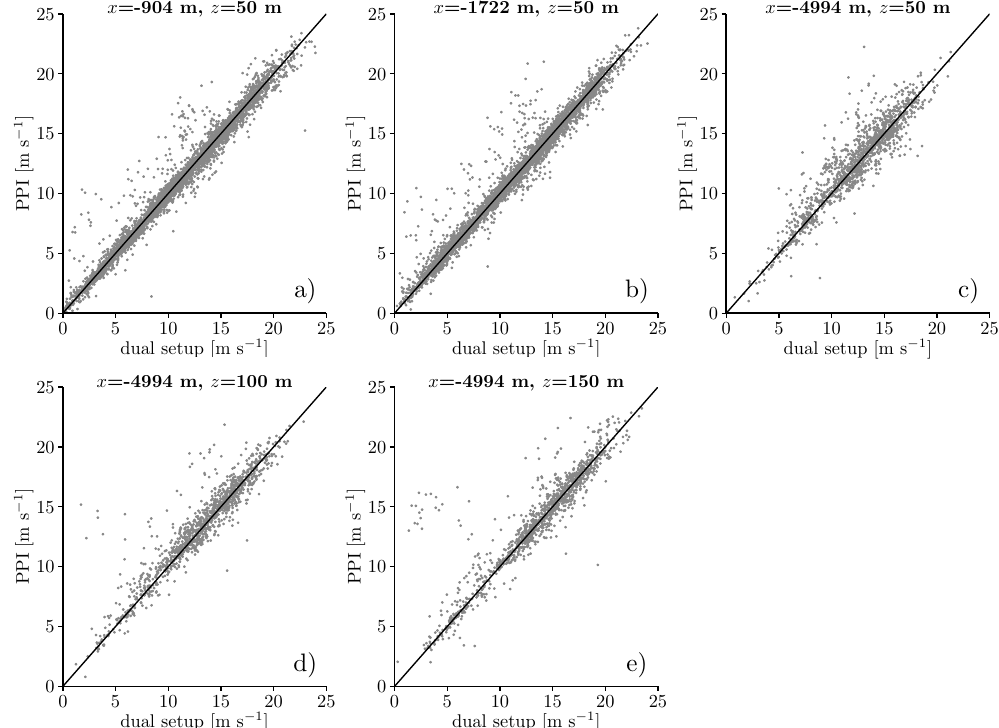
Figure 10. Scatter plots of the 10 min mean wind speeds for the PPI and dual setups (see text for details). A line through the origin with a slope of 1 is shown in black. The x -position is relative to position 2 of Vara with positive values going eastward and the z -position is ASL. Scatter plots at positions of 1700 and 5000 m west of position 2 of Vara are shown in panel ( a , b ) and ( c – e ),